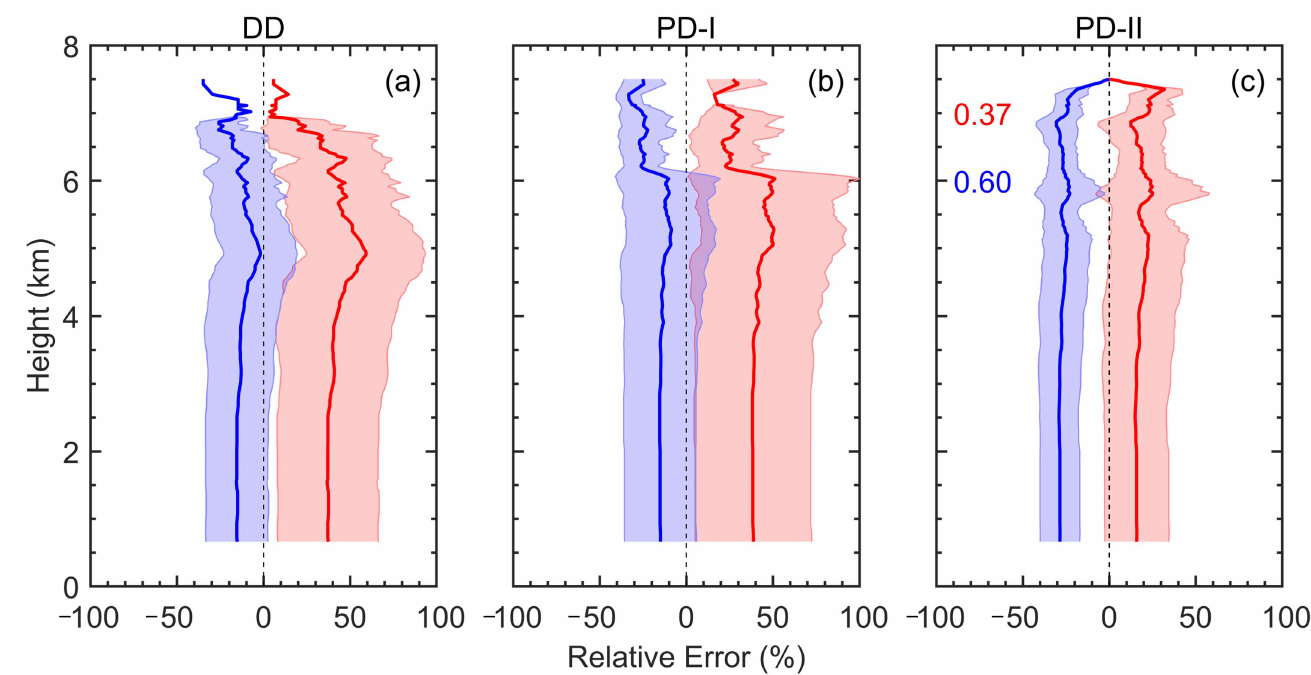
Figure 8. The vertical distribution of the relative error (RE) of the DMC introduced for the dust MEE of 0.37 (red) and 0.60 (blue) m 2 g − 1 ,